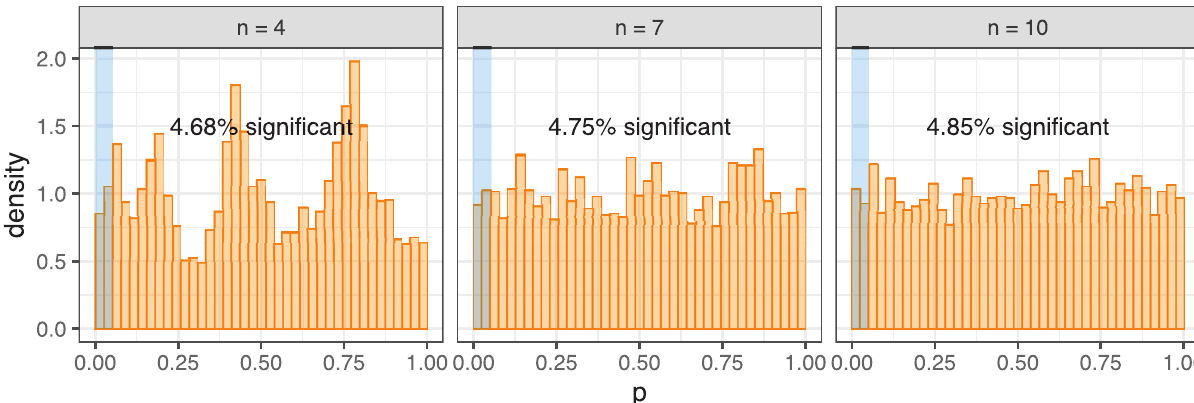
Fig 4. Calibration of the exact gene pair placement test with Monte Carlo smoothing. Smoothing the exact gene pair placement test in Fig 3 by adding noise to the rates, we observe good calibration and the desired uniform distribution of p-values under the null for the larger n .